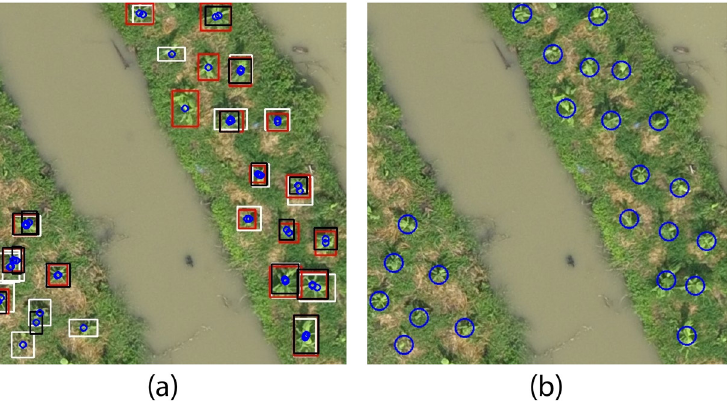
Fig 7. Merging detection results on a sample ROI tile of 40m. (a) Bounding boxes from LCS (Black), SCT (White) and TGI (Red), and their centroids (small blue circles) on a sample image tile of ROI. (b) Merged centroids by taking euclidean distance threshold of 30 pixels are represented by blue circles of 15px